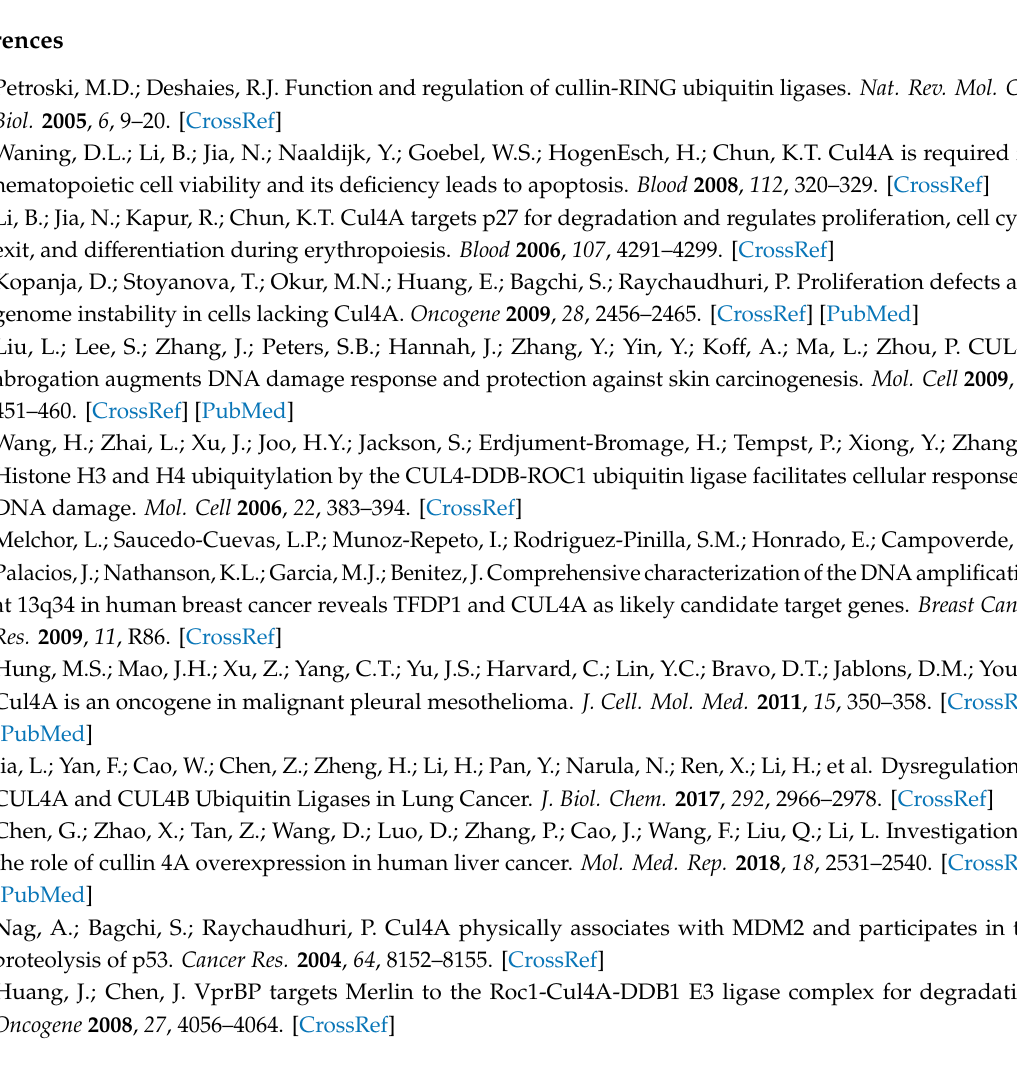
Figure S1: ROC curve of the Cul4A